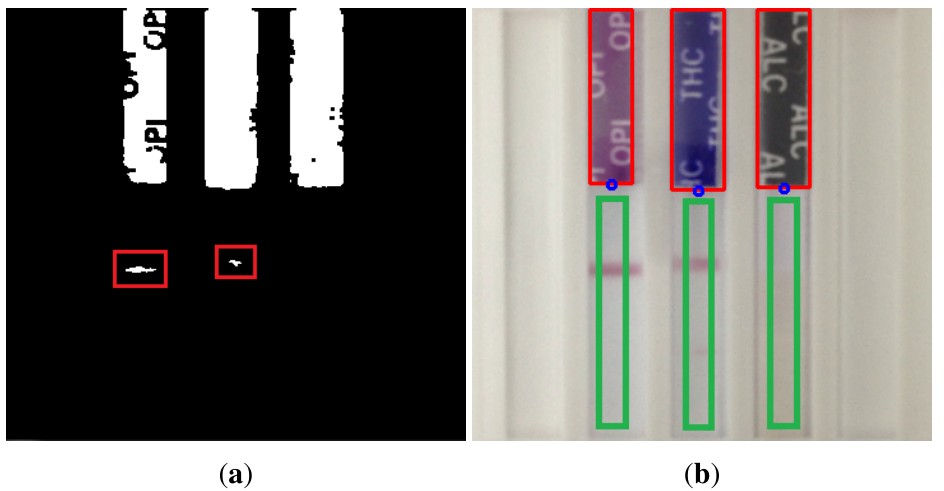
Figure 6. ( a ) Result of the segmentation process on a test image. Spurious contours, bounded in red, are filtered out during the post-processing stage; ( b ) Localization of the colored area of the strips after applying the segmentation process to a test image, bounded with a red rectangle. For each of these regions, its size is used together with the position of its bottom-middle point (depicted in blue) as parameters to automatically determine the region on which the lateral histogram will be computed, bounded with a green